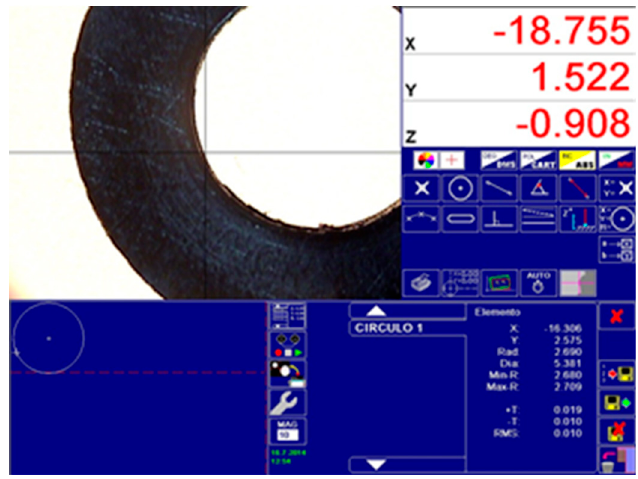
Figure 10. Details of the inner diameter measurement with profile projector TESA VISIO.